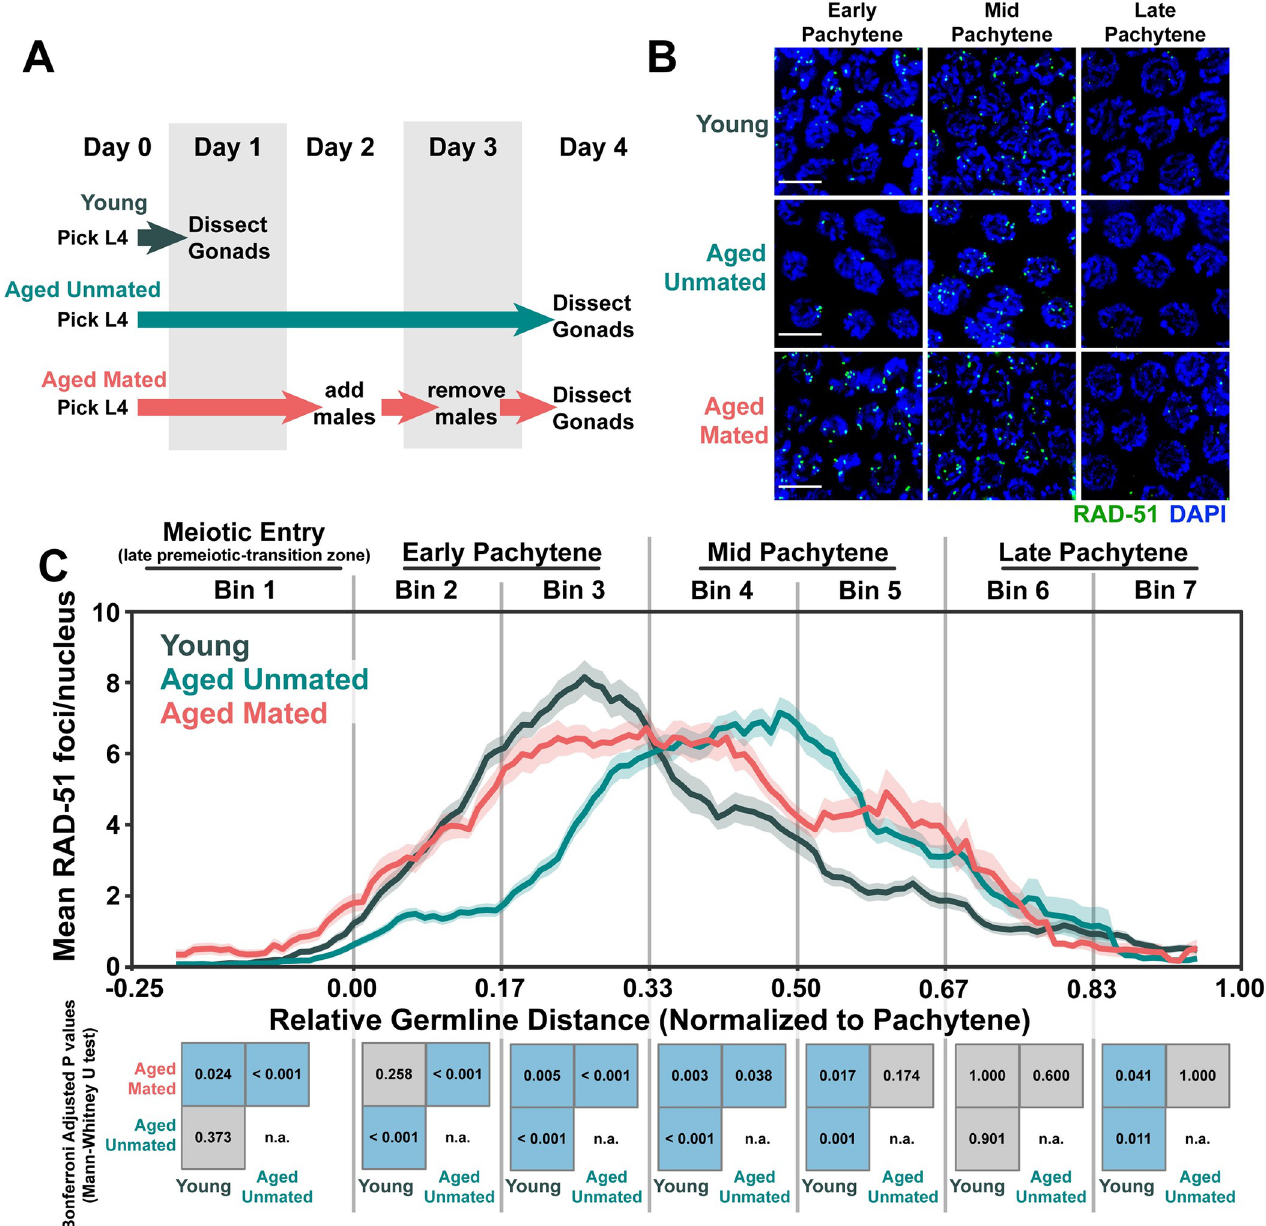
Fig 1. DNA double strand break levels are altered during C . elegans germline aging. A) Schemes used to isolate young (1 day post-L4) and aged (4 days post L4) worms for experiments. Days count ~18–24 hour periods after hermaphrodites were isolated as L4 larvae and are separated by alternating grey shaded boxes. B) Representative images of RAD-51 foci in meiotic nuclei of young and aged germlines. Scale bars represent 5 μ m. C) RAD-51 foci per nucleus in oocytes. Line plots represent the mean RAD-51 foci per nucleus along the length of the germline in a sliding window encompassing 0.1 units of normalized germline distance with a step size of 0.01 germline distance units. Mean RAD-51 foci were calculated from nuclei analyzed in n = 9 total germlines derived from � 3 experimental replicates within each age group. Shaded areas around each line represent ± SEM. Total nuclei analyzed (Bins 1/2/3/4/5/6/7) Young: 185/117/146/107/117/97/83; Aged Mated: 234/205/192/173/154/177/96; Aged Unmated: 268/147/161/175/191/152/110. Germline distances were normalized to the start (0) and end (1) of pachytene based on DAPI morphology (see Methods). For analysis, the germline was divided into 7 bins encompassing the transition zone (Bin 1), early pachytene (Bins 2–3), mid pachytene (Bins 4–5), and late pachytene (Bins 6–7). The germline positions at which each bin start and end are marked on the X axis as vertical grey lines. Heat maps below each bin display the p values of pairwise comparisons of RAD-51 foci per nucleus counts within that bin. P values were calculated using Mann-Whitney U tests with Bonferroni correction for multiple comparisons. Blue tiles indicate significant differences (adjusted p value < 0.05) and grey tiles indicate nonsignificant effects (adjusted p value > 0.05). n.a. = not applicable. Numerical data associated with this figure is presented in S1